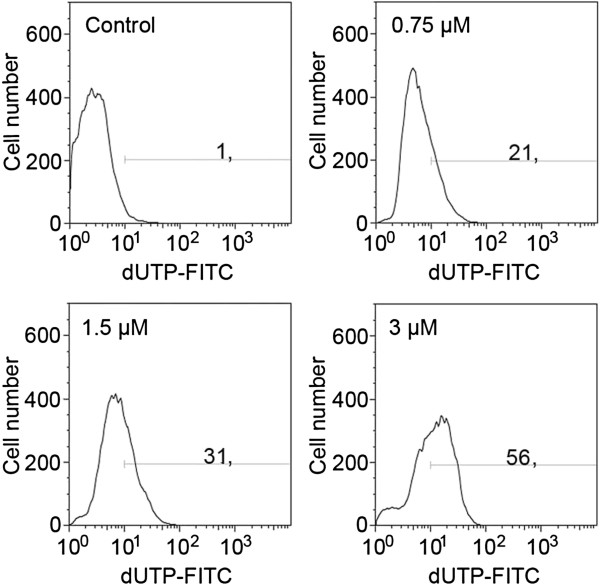
DNA fragmentation rate in A549 cells after treatment with etoposide - representative histograms from flow cytometric analyses (the TUNEL method); upper left - control cells, upper right - 0.75 μM etoposide, lower left - 1.5 μM etoposide, lower right - 3 μM etoposide.